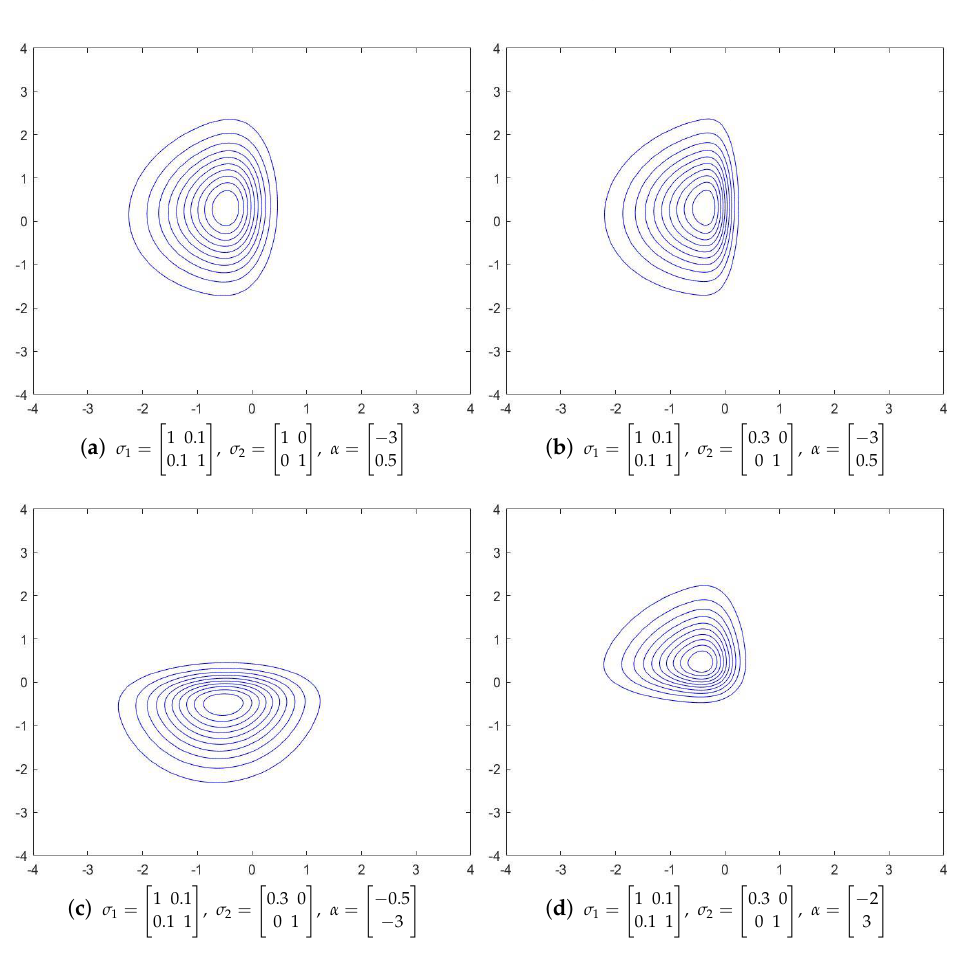
Figure 3. Various threat function shapes by MSN distribution: ( a ) basic shape; ( b ) changing the degree of distortion; ( c ) changing direction toward the south; ( d ) changing direction toward the